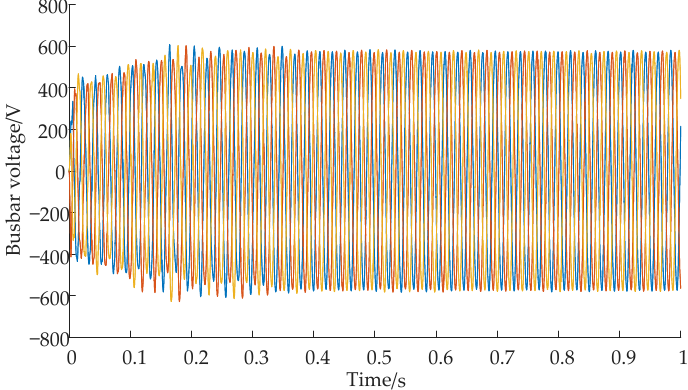
Figure 15. The bus voltage waveform when n 1 = 0.001 V/var and n 2 = 0.002 V/var.